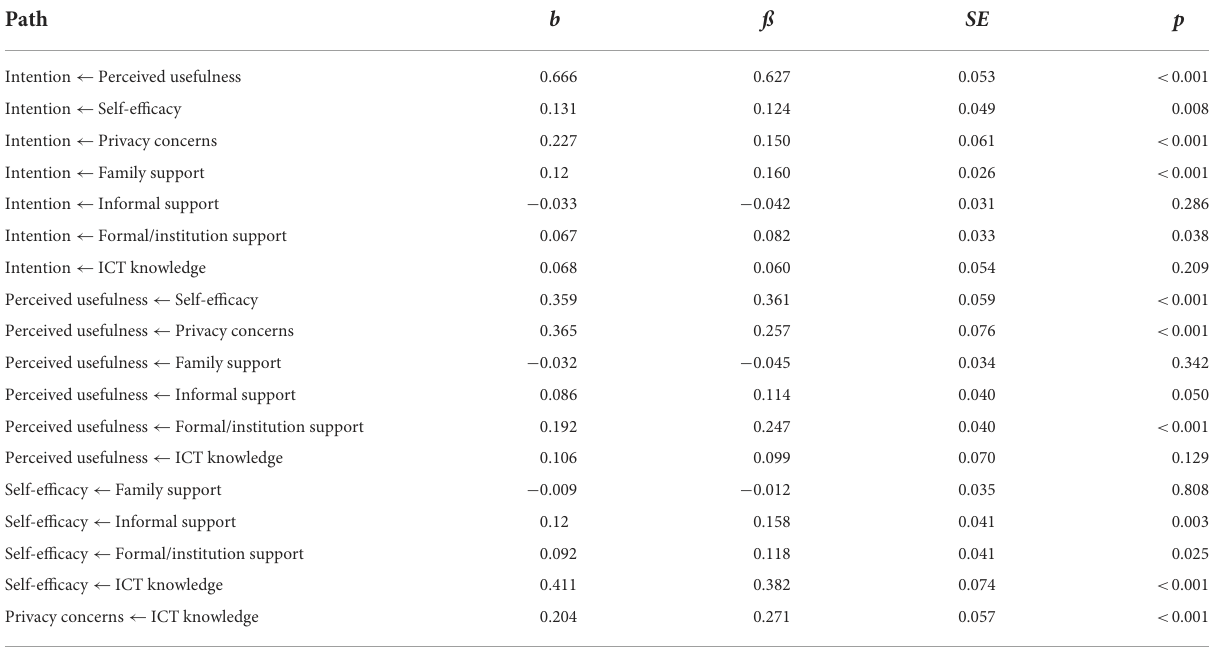
TABLE 2 Results of the study variables in the structural equation model for digital health services.